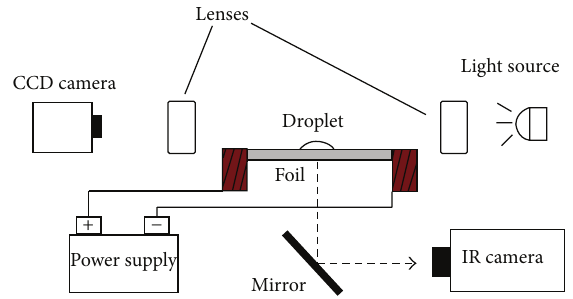
Figure 1: The scheme of the